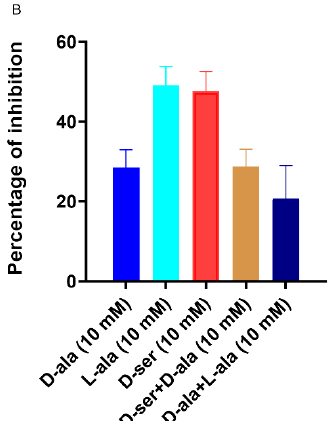
Figure 7. Reversal of C . jejuni 11168-O biofilm inhibition by ( A ) D-Cycloserine (DCS), ( B ) L-ala and D-ser in presence of D-alanine (D-ala). The data is presented as Mean ± Standard errors of Percentage of inhibition (Normalized to untreated control).